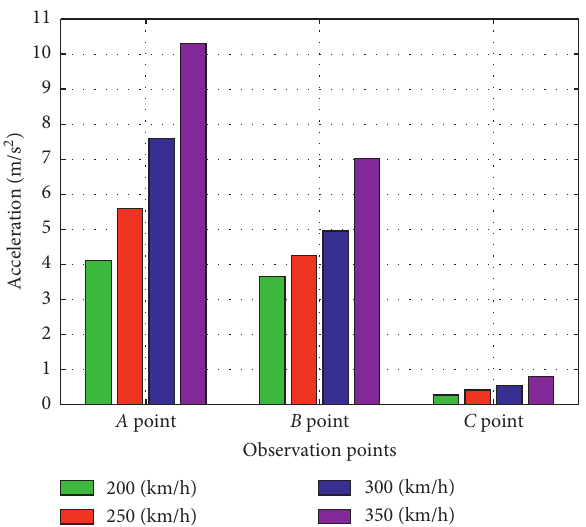
Figure 8: The speed effect on the vertical accelerations at the observation points of A, B, and C.